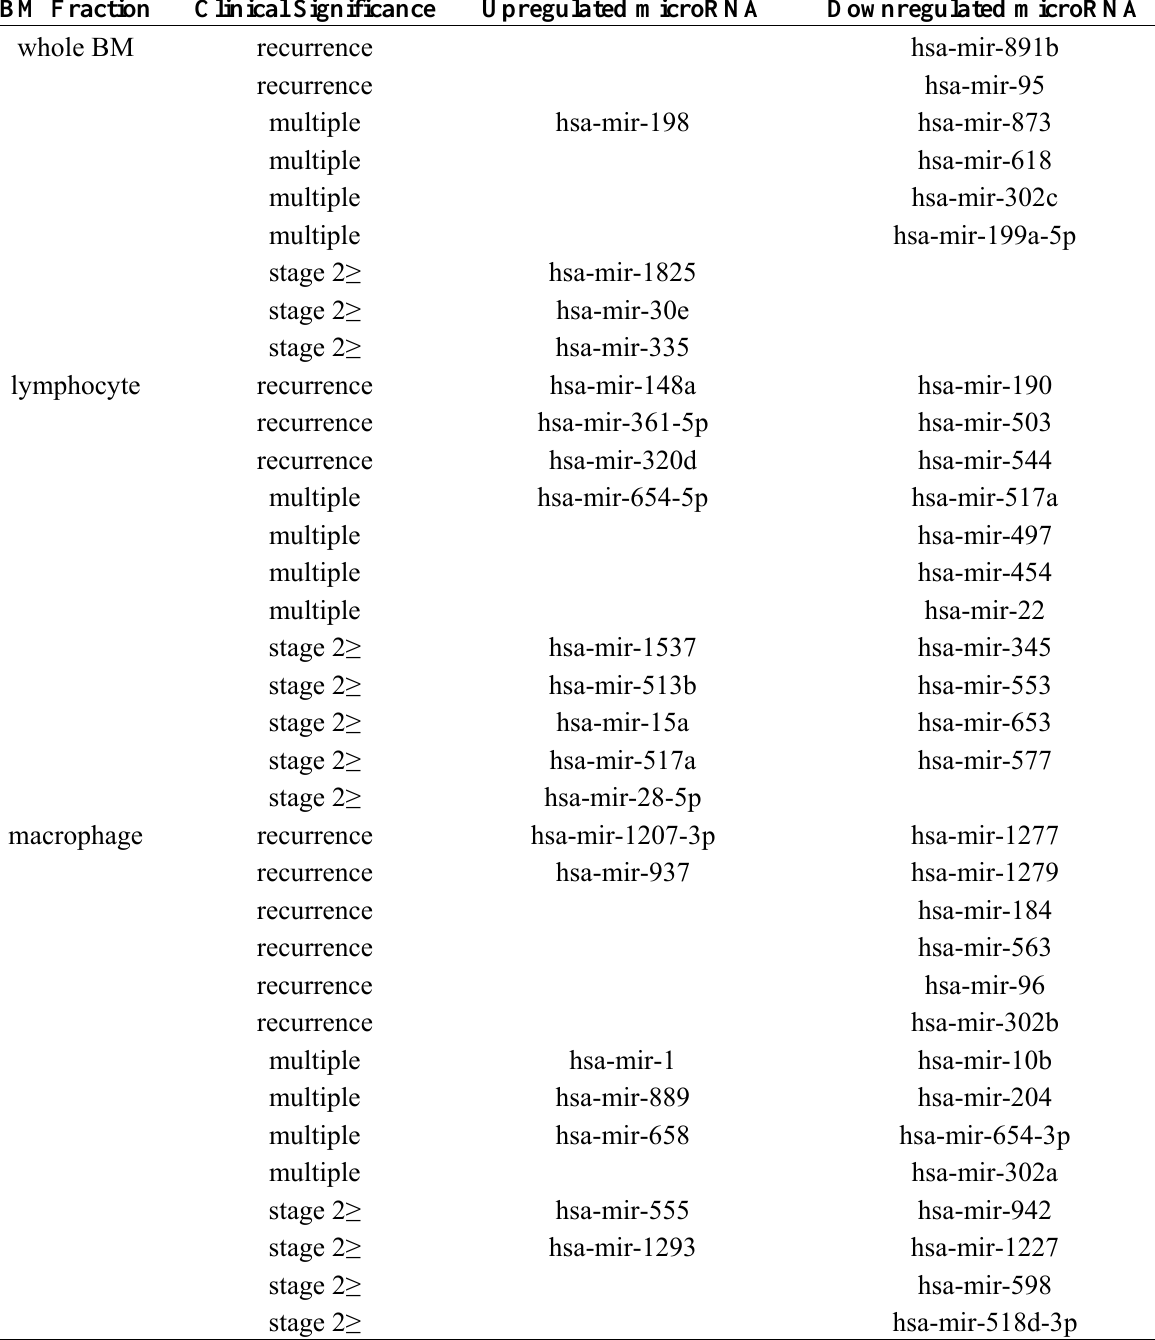
Table 1. MicroRNAs in the bone marrow cells that were significantly correlated with clinical significance of HCC